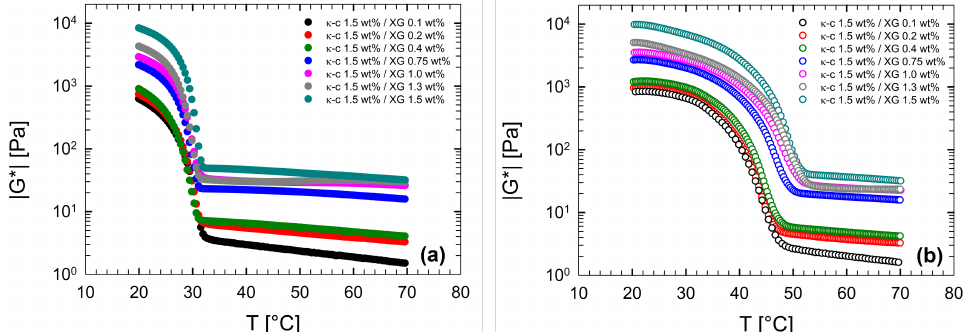
Figure 8. Complex modulus as a function of temperature, at 1 ◦ C/min, for solutions with 1.5 wt% of κ -c at different XG amounts. ( a ) Cooling, and ( b ) heating